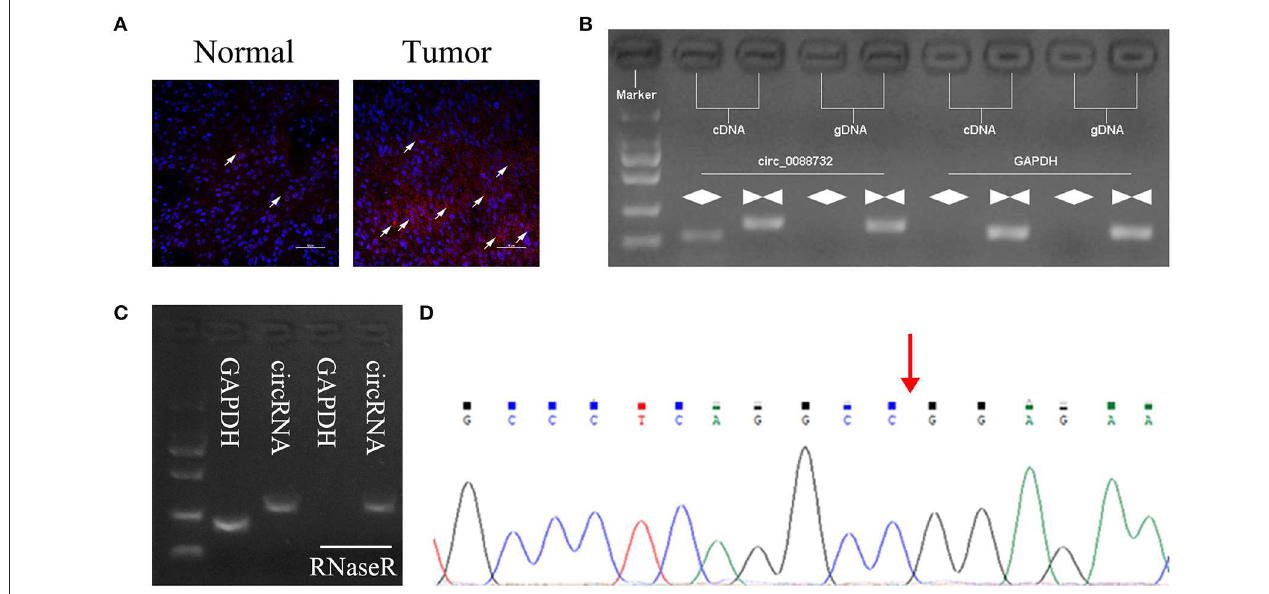
FIGURE 1 | Identification of hsa_circ_0088732. (A) Fluorescence in situ hybridization (FISH) was performed to show the levels and locations of Lcn2-derived circRNA (hsa_circ_0088732) expression. Red indicates circRNA and blue indicates nuclei (DAPI). The white arrow indicates hsa_circ_0088732. Magnification, × 200; Scale bar = 100 µ m. (B) The linear and circular Lcn2 in cDNA and gDNA were amplified by using convergent and divergent primers, respectively. (C) qRT-PCR was used to analyze the expression of GAPDH and hsa_circ_0088732 RNA after treatment with RNaseR. (D) Sanger sequencing was used to verify the circular structure of hsa_circ_0088732; red arrow shows the site of the backsplice